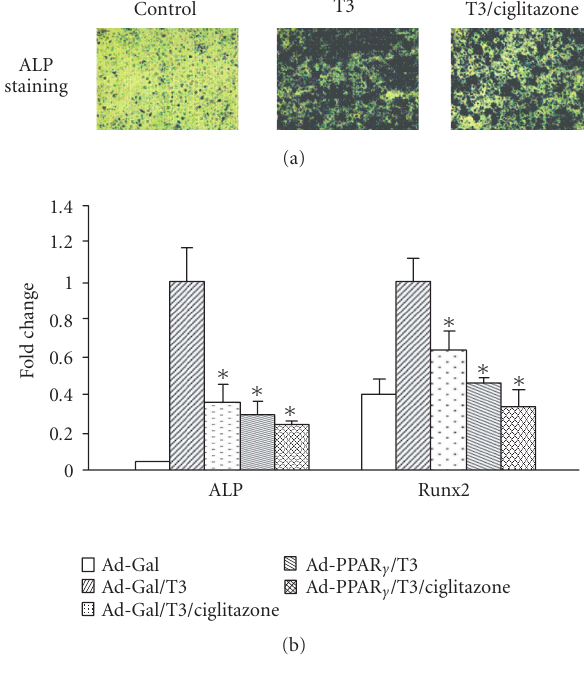
Figure 5: Inhibition of T3-induced hypertrophy and mineraliza- tion in the growth plate cells by PPAR γ overexpression or cigli- tazone treatment. (a) Growth plate cells were treated with T3 (100ng/mL) in the presence or absence of ciglitazone (5 μ M) for 10 days. Alkaline phosphatase (ALP) staining was used as a marker of terminal di ff erentiation of growth plate chondrocytes. Positive stainings were colored in dark blue. Negative-stained background was colored in light green. (b) Quantitative PCR analysis of ALP and Runx2 genes 4 days after growth plate cells were infected with Ad-PPAR γ or treated with ciglitazone. Ad-Gal-infected cells with- out T3 or ciglitazone treatment were used as controls. Gene expres- sion levels were normalized with respect to endogenous 18S rRNA. ∗ P < . 05 versus the expression in the Ad-Gal-infected cells with T3-